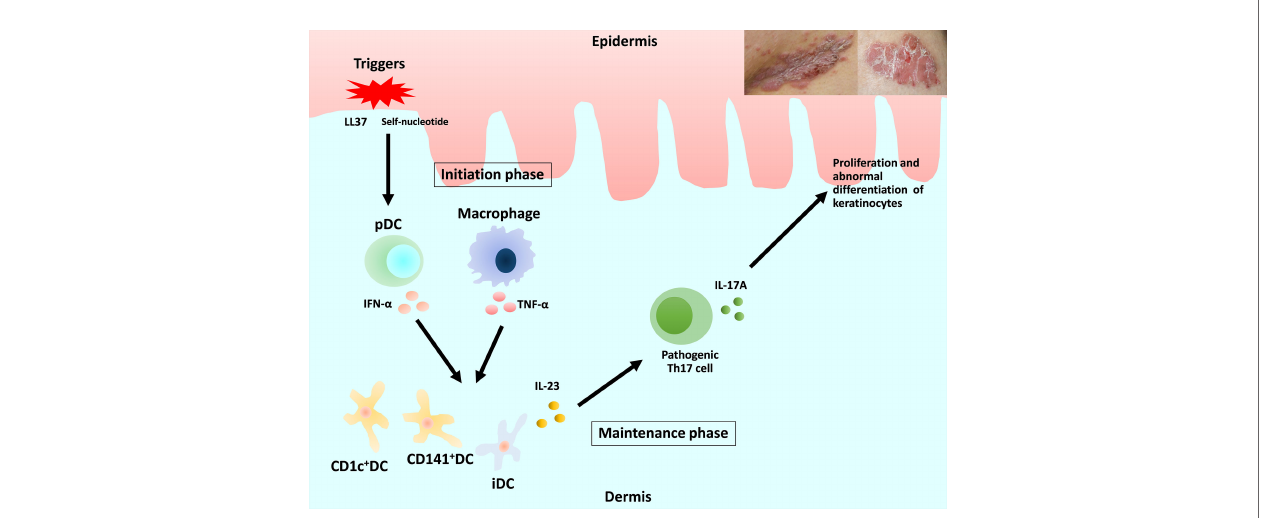
FIGURE 1 | Overview of the current understanding of the pathogenesis of psoriasis and the roles of dendritic cells and macrophages. DC, dendritic cells; pDC, plasmacytoid DC; iDC, in fl ammatory